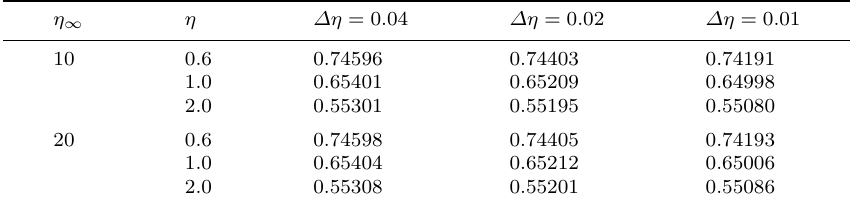
Table 5. Grid-invariance test for velocity